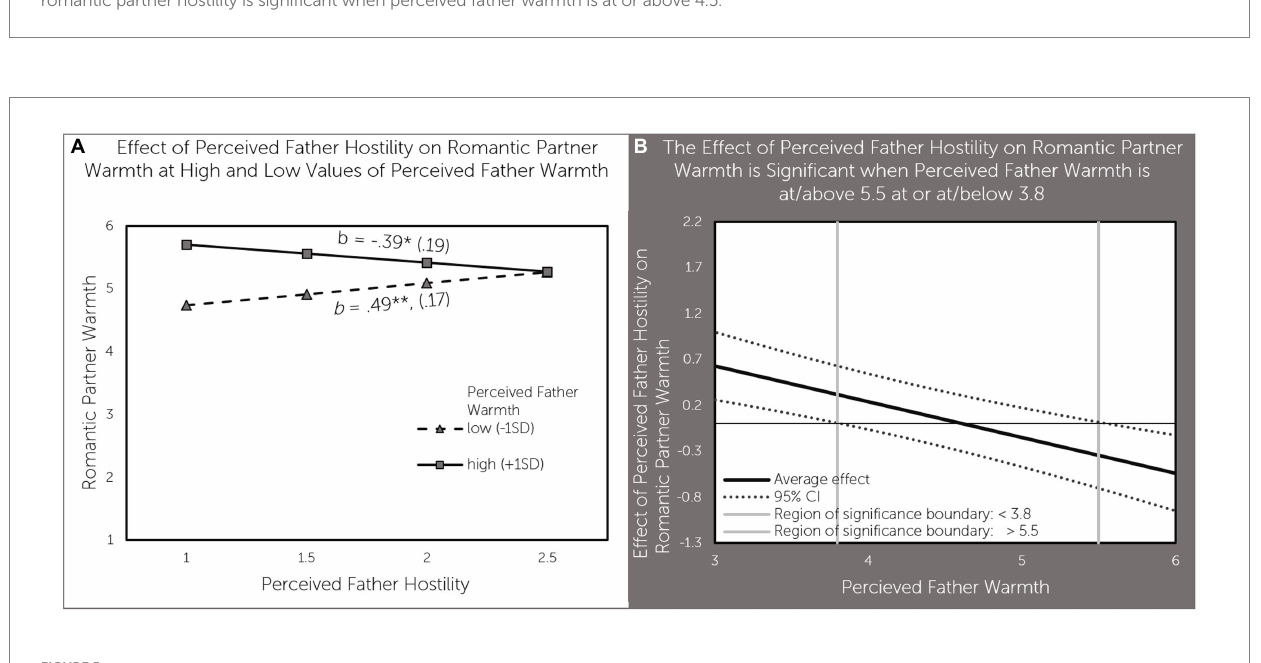
FIGURE 5 Perceived father warmth moderates the effect of perceived father hostility on daughter’s romantic partner warmth (A) effect of perceived father hostility on romantic partner warmth at high and low values of perceived father warmth; (B) The deleterious effect of perceived father hostility on romantic partner warmth is significant when perceived father warmth is at or above 5.5; a positive effect of perceived father hostility on romantic partner warmth is significant when perceived father warmth is at or below